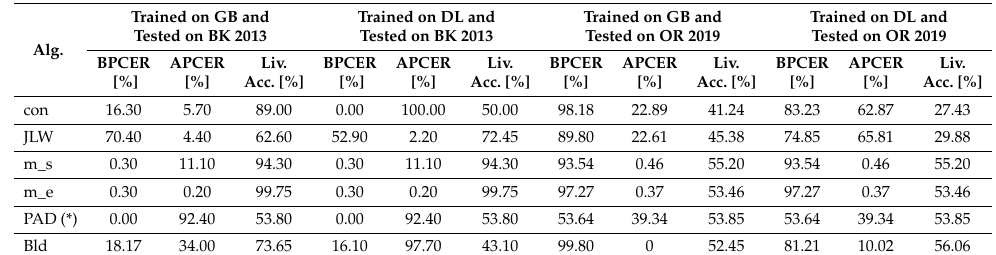
Table 7. Results of LivDet 2021 competitors on LivDet Biometrika 2013 and LivDet Orcanthus 2019 test sets. (*) indicates training on both GreenBit and Dermalog Livdet training sets. Trained on GB and Tested on BK Alg.